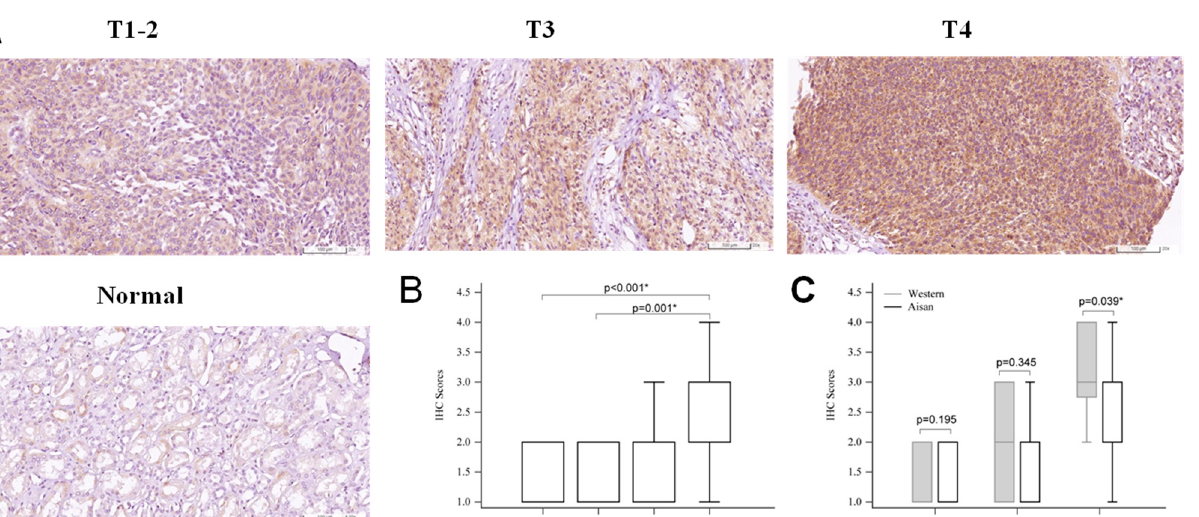
display stronger FGFR3 signals (score 2+~3+).